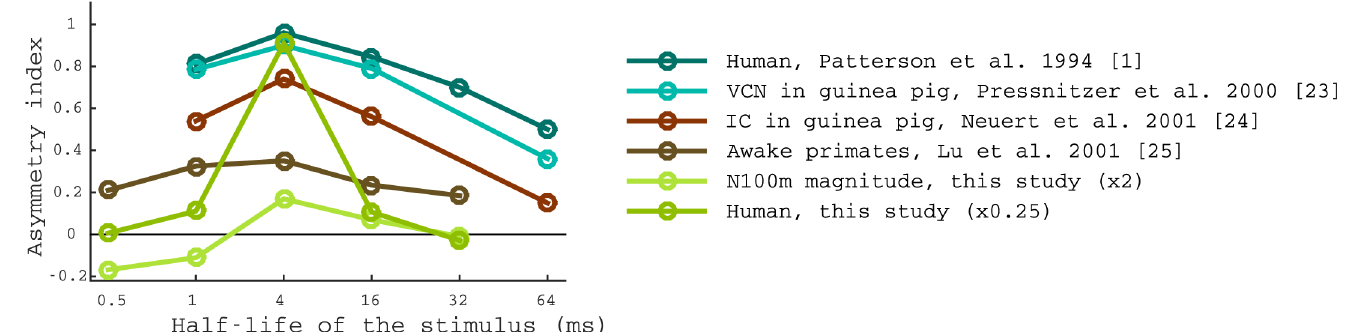
Fig 10. Comparison between our results and previously reported measures of the perceptual asymmetry between ramped and damped sinusoids. Comparison between asymmetry preference of ventral cochlear nucleus [23], inferior colliculus [24], cortical neurons [25], human psychophysical performance in discriminating the ramped and damped sinusoids in A1 [1], the N100m magnitude temporal asymmetry, and psychophysical perceptual asymmetry measured in this work. Multiplicative factors (2 and 0.25, respectively) were applied to rescale the results of our study in order to improve visualisation. Note that the absolute values of the indices depend on the individual scale of each